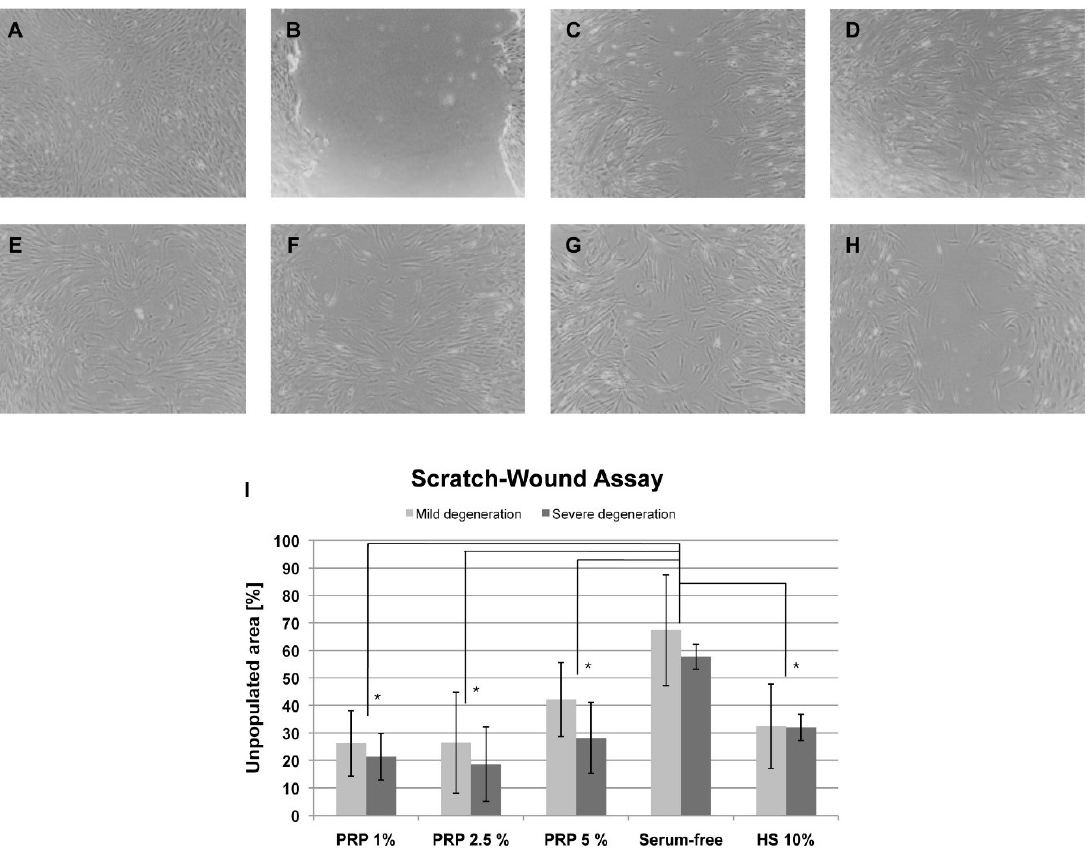
Figure 2. Scratch-wound assay. Exemplarily shown cell layer before the scratch ( A ), directly after the scratch ( B ), and the closing scratch-wound after 24 h ( C ) and 48 h ( D ) using medium containing 2.5% PRP reveal the closure of the gap. For comparison, exemplary images of the closing gap after 48 h were given for 1% PRP ( E ), for 5% PRP ( F ), 10% human serum supplemented medium ( G ), and for serum-free medium ( H ) (magnification of all images 40 × ). The unpopulated area at 48 h as a percentage of the area directly after the scratch ( I ) reveals the lowest open area with a concentration of 2.5% PRP for AF cells derived from mildly and severely degenerated AF tissue (* p < 0.05). Values of the unpopulated area were given as mean values of 3 donors with mild and severe disc degeneration each. Cells of each donor were measured in triplicates (error bars: standard deviation).